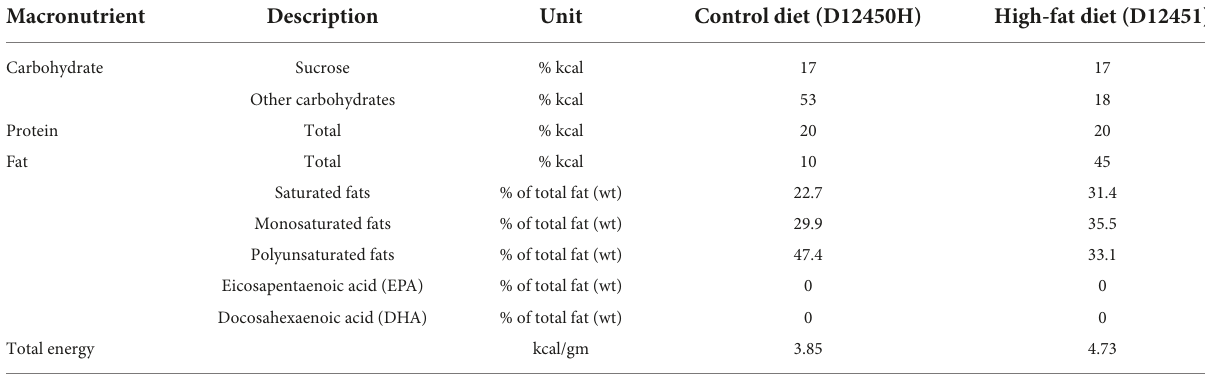
TABLE 1 Nutritional content of control and high-fat diets provided to rat dams during pregnancy and lactation.